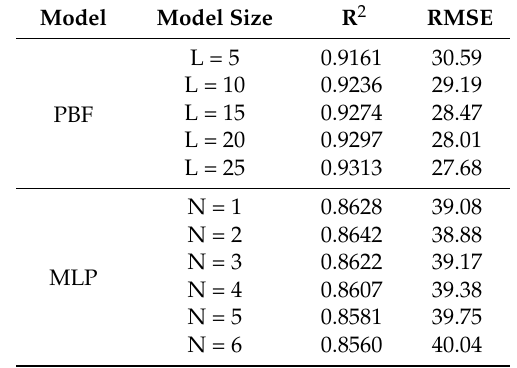
Table 1. PBF and MLP–ANNs models performance results. RMSE: root-mean-square error, R 2 :